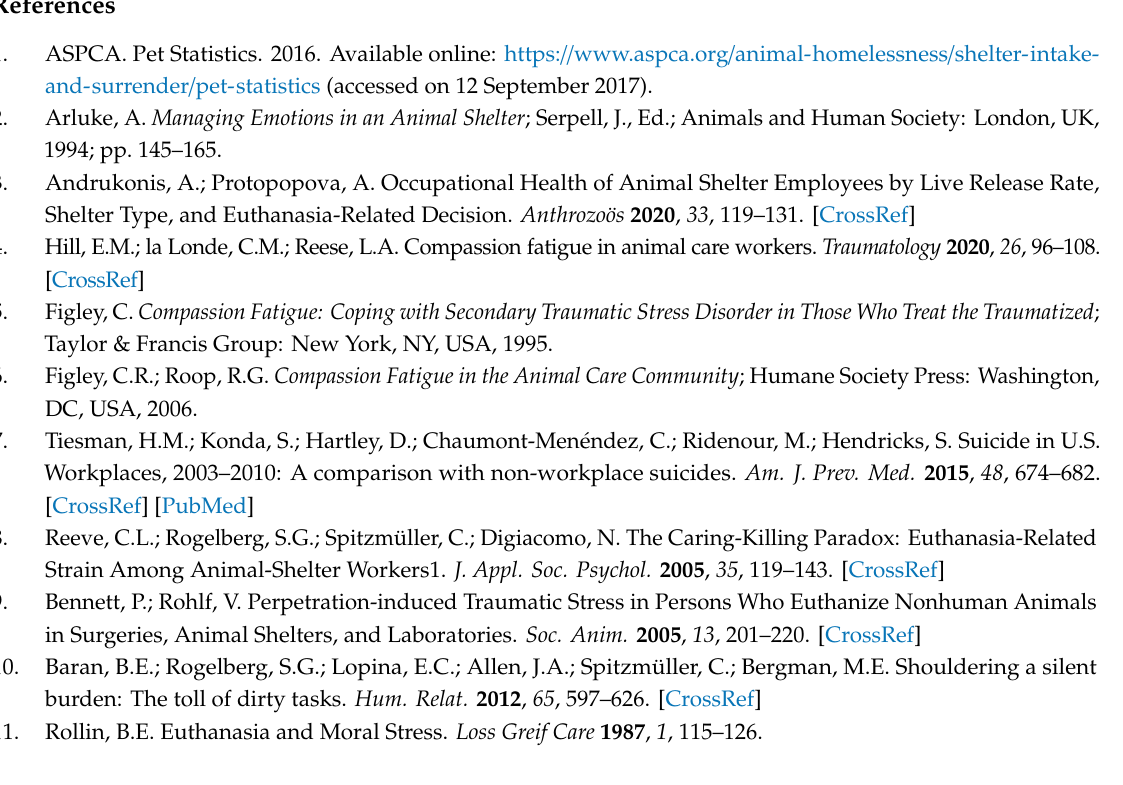
Table S1: Experiment 1 Analysis, Table S2: Experiment 2